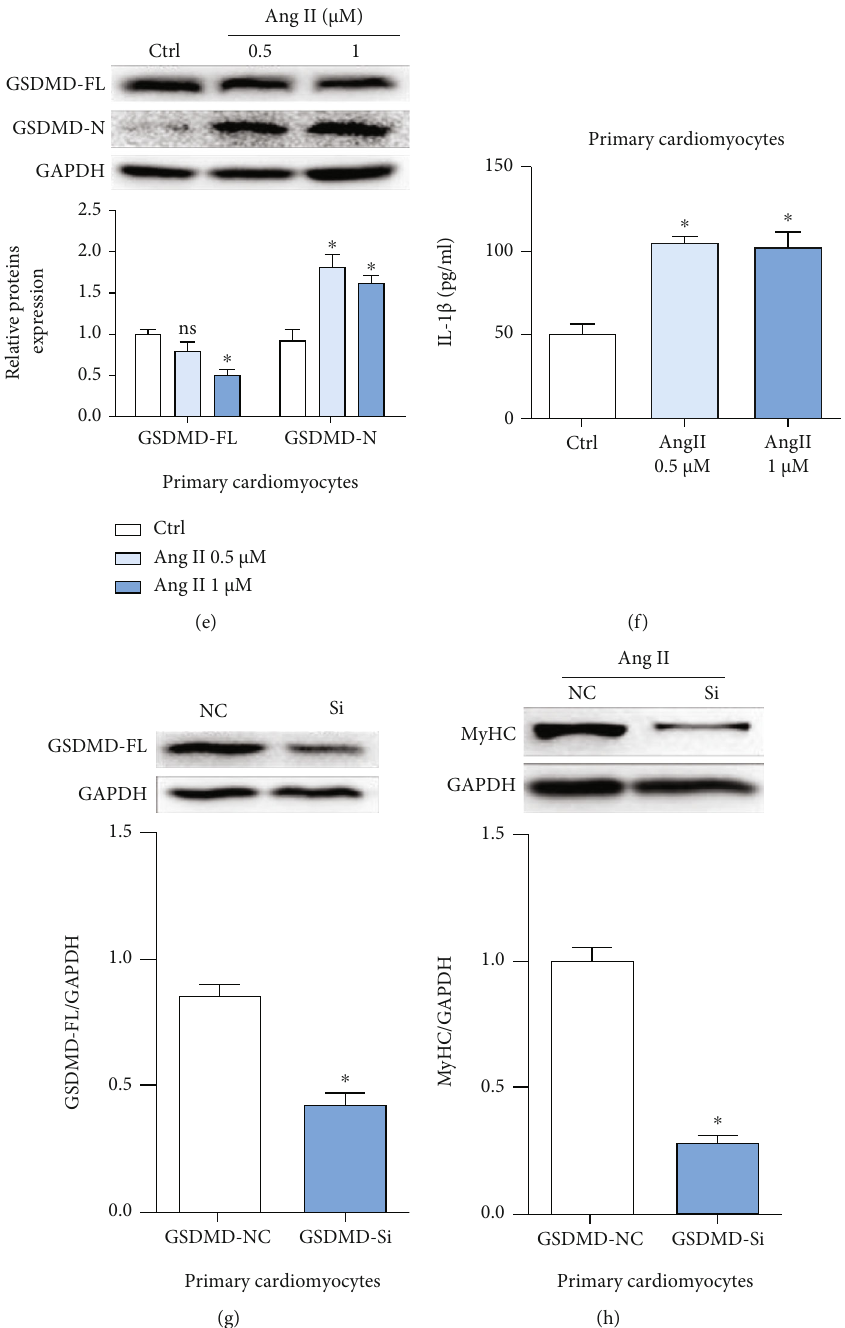
Figure 3: Inhibition of GSDMD alleviated hypertrophy caused by Ang II. (a, e) Gel images of GSDMD-FL and GSDMD-N in H9c2 and neonatal rat cardiomyocytes incubated with Ang II (0.5, 1 μ M); the semiquantitative statistical graph is shown. (b, f) The supernatant in IL-1 β levels gauged by ELISA kits. (c, g) Gel images of GSDMD after knockdown by siRNA; the relevant statistical graph is shown. (d, h) Levels of hypertrophy indicator MyHC were detected in cell lysates after knockdown by siRNA, and the relevant statistical graph is shown. ∗ p < 0 : 05 compared with control; # p < 0 : 05 compared with Ang